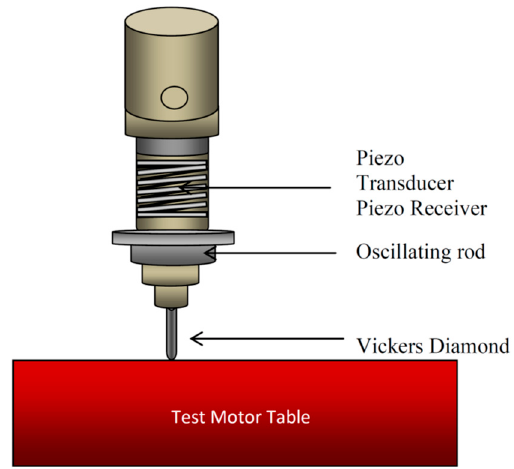
Figure 3. The ultrasonic contact impedance (UCI) method (MIC 10, MIC 20).